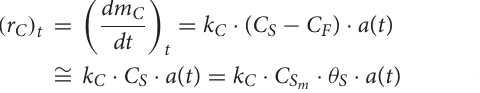
2013), its intrinsic activity is quite less than that of Ni.